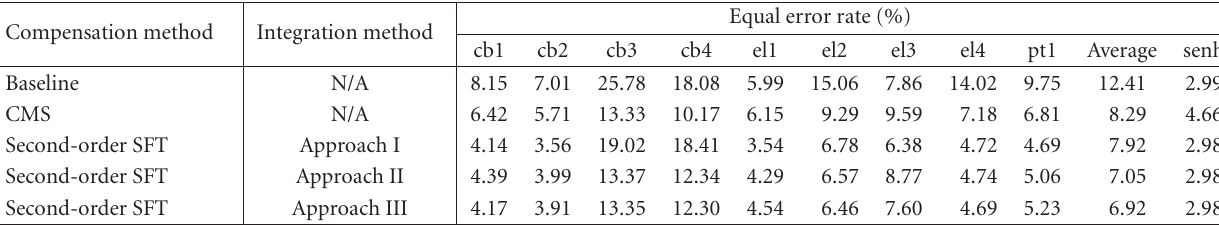
Table 4: Results for seen and unseen handsets with di ff erent characteristics. Equal error rates (%) are achieved by the baseline, CMS, and the three handset selector integration approaches shown in Table 3, with handsets cb3 and cb4 being used as the unseen handsets. The enrollment handset is senh. The average handset identification accuracy is 98.25%. Note that the baseline and CMS do not require the handset selector. Second-order SFT stands for second-order stochastic